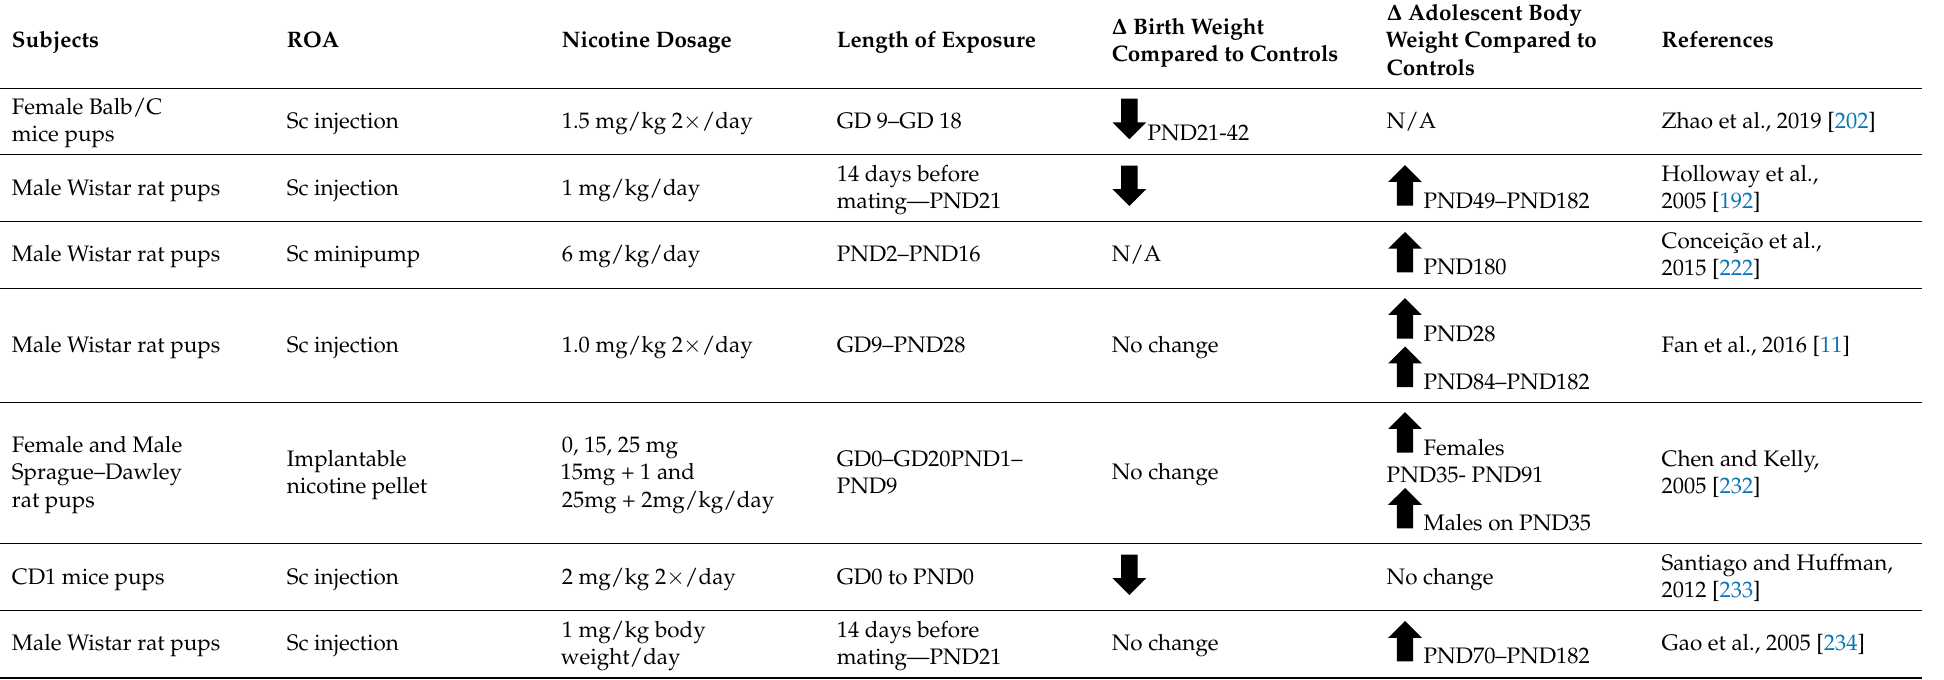
Table 2. Prenatal Nicotine Effects on Body Weight in Rodents.